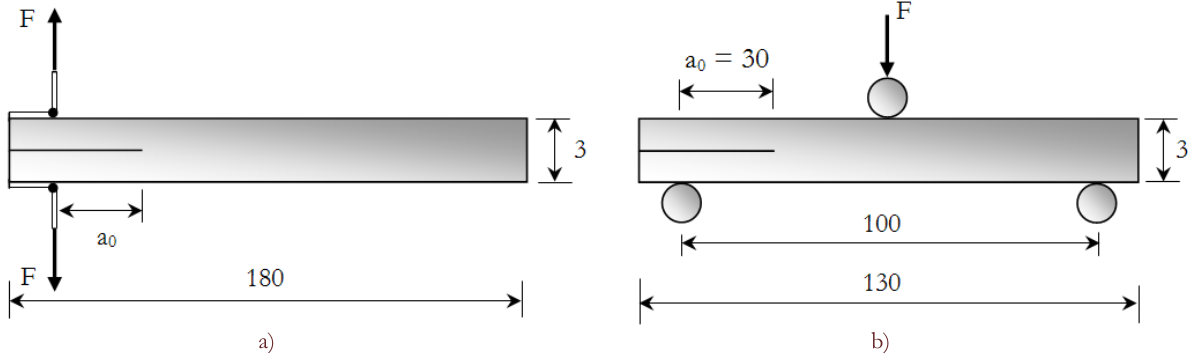
Figure 2: a) DCB specimen (Mode I); b) ENF specimen (mode II). Dimensions in